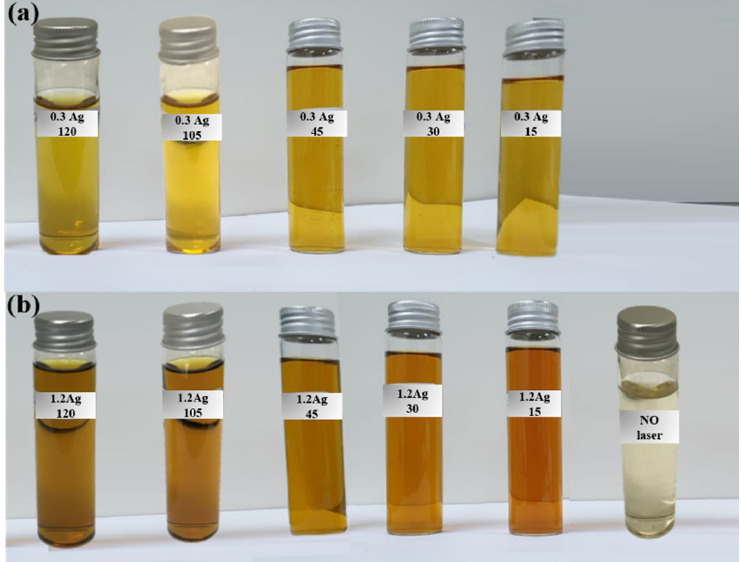
Figure 2. The prepared samples of two concentrations of Origanum majorana extract solution: ( a ) 0.3 mL and ( b ) 1.2 mL at different irradiation times.